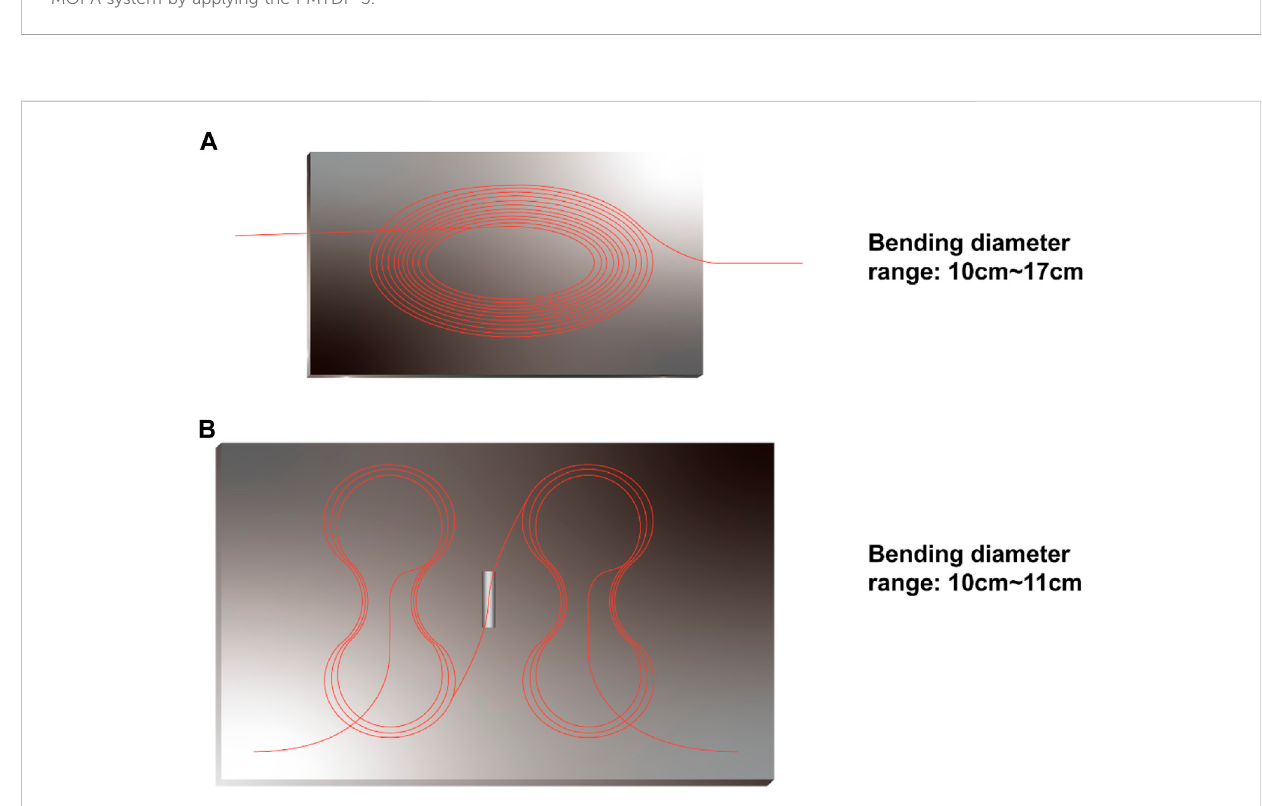
FIGURE 4 TheresultsoftheMOPAsystembeforeandafteradding200 mPMGDF. (A) Thespectraofseed. (B) Thebackwardpowerversusthelaserpowerofa MOPA system by applying the